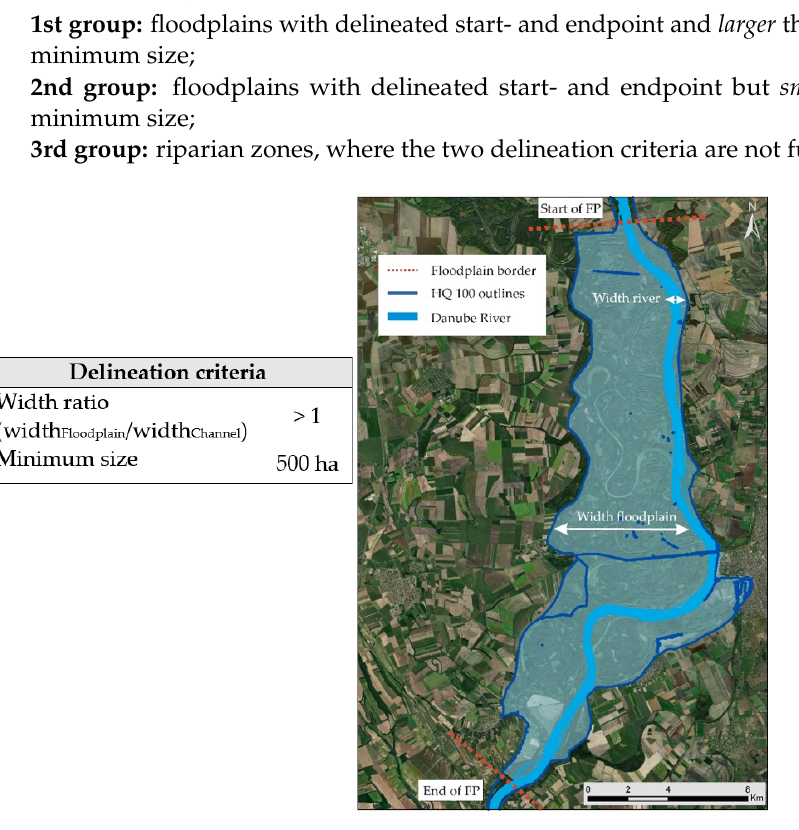
Figure 1. Left : Applied delineation criteria for identifying active floodplains along the Danube River. Right : Identified floodplain HU_DU_AFP07 (HU = Hungary, DU = Danube River, AFP = active floodplain) showing the concept of locating the start- and endpoint of a floodplain based on the width ratio (width Floodplain /width Channel ).